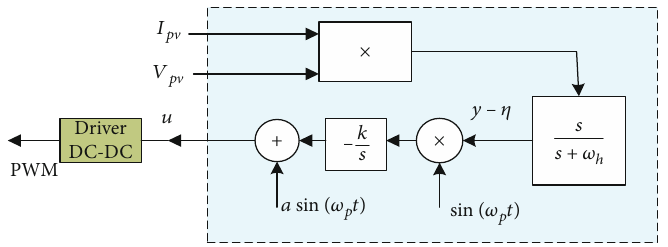
Figure 6: Block diagram of the conventional ESC algorithm applied to the PV system.